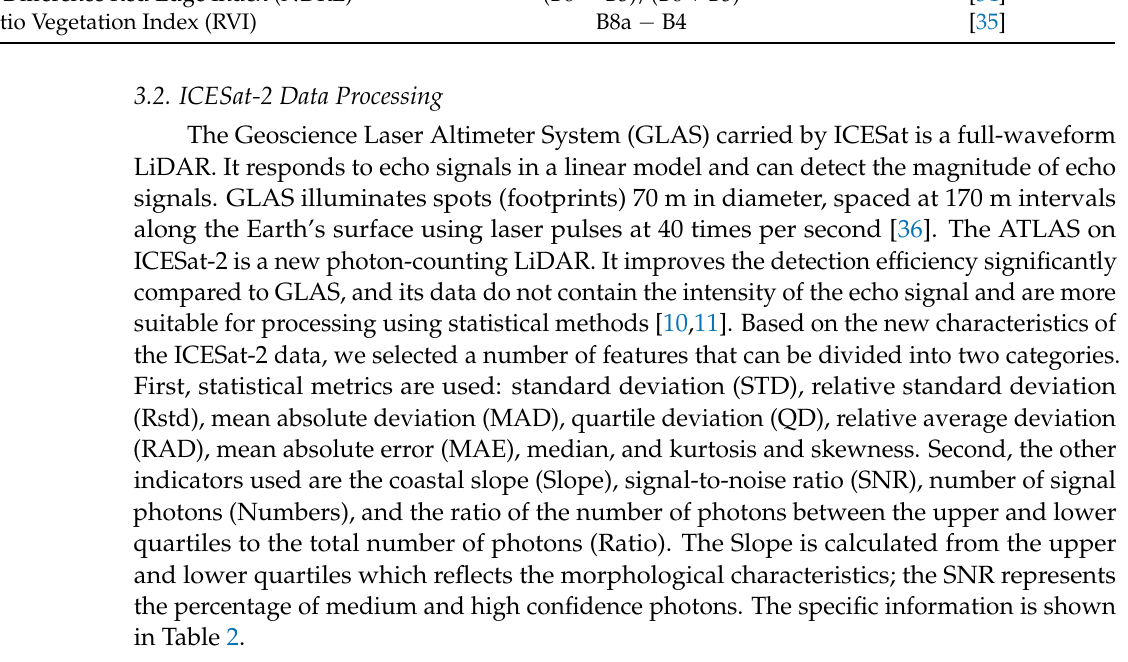
Table 2. ICESat-2 characteristic variables and